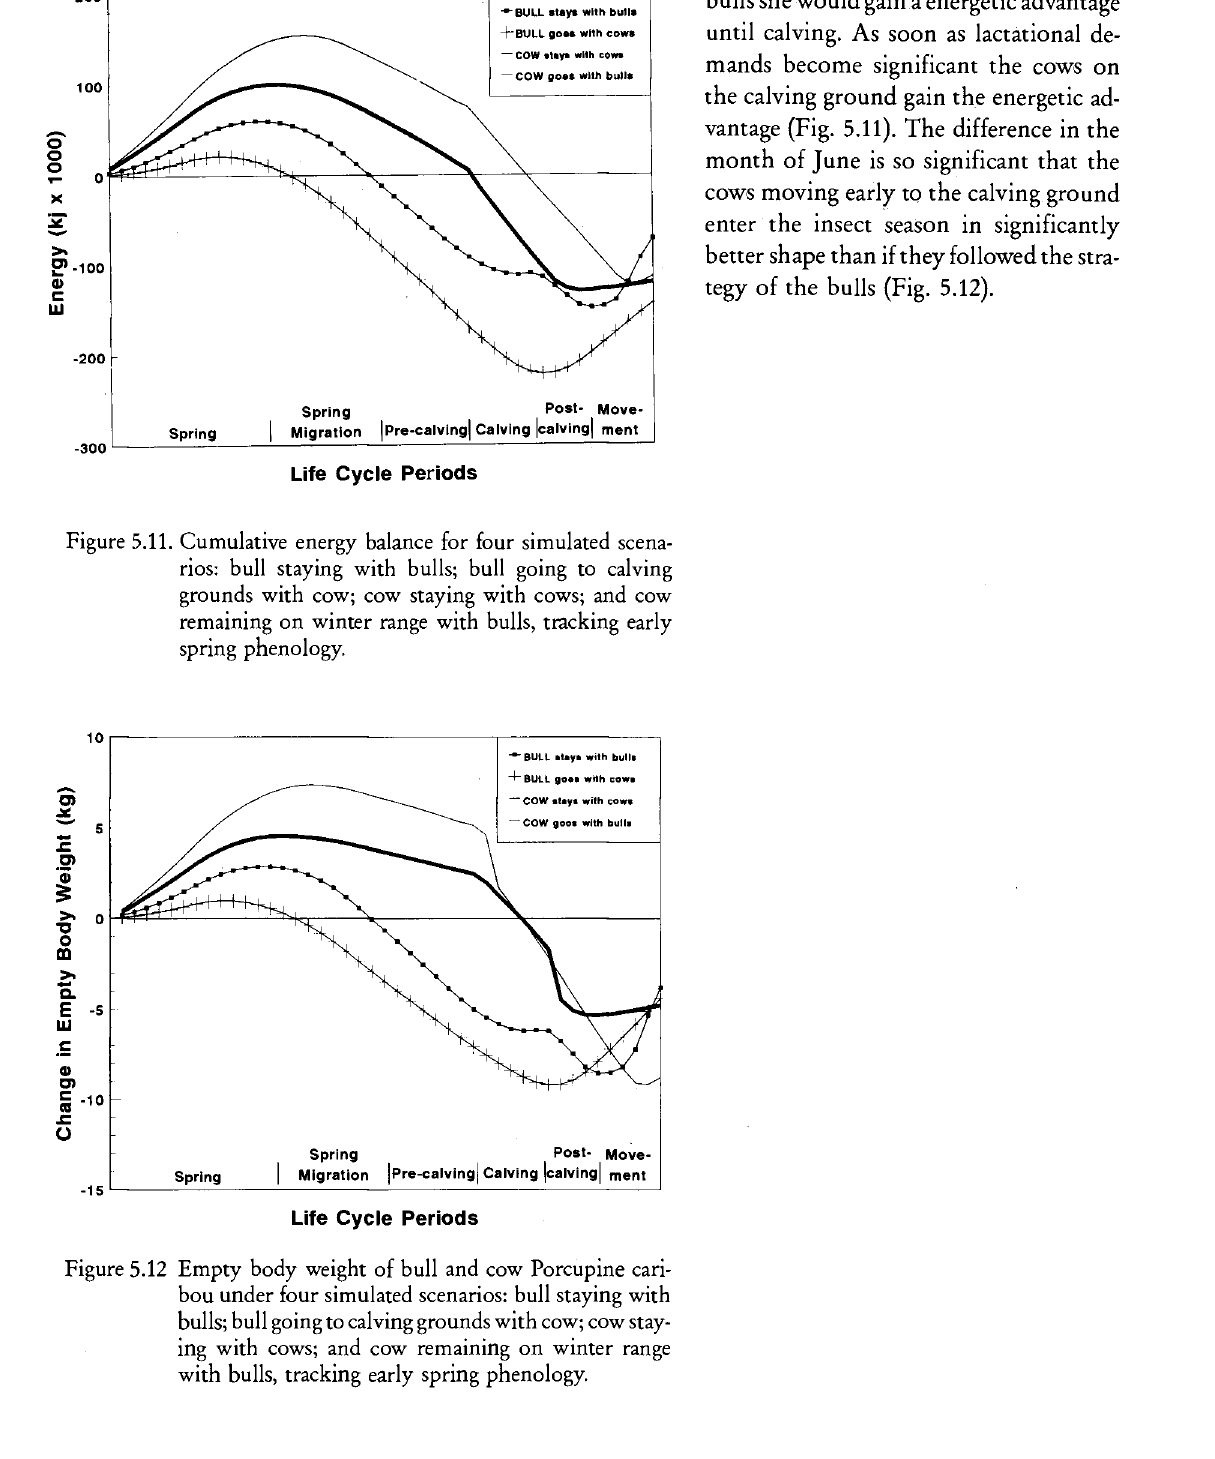
Figure 5.12 Empty body weight of bull and cow Porcupine cari bou under four simulated scenarios: bull staying with bulls; bull going to calving grounds with cow; cow stay ing with cows; and cow remaining on winter range with bulls, tracking early spring